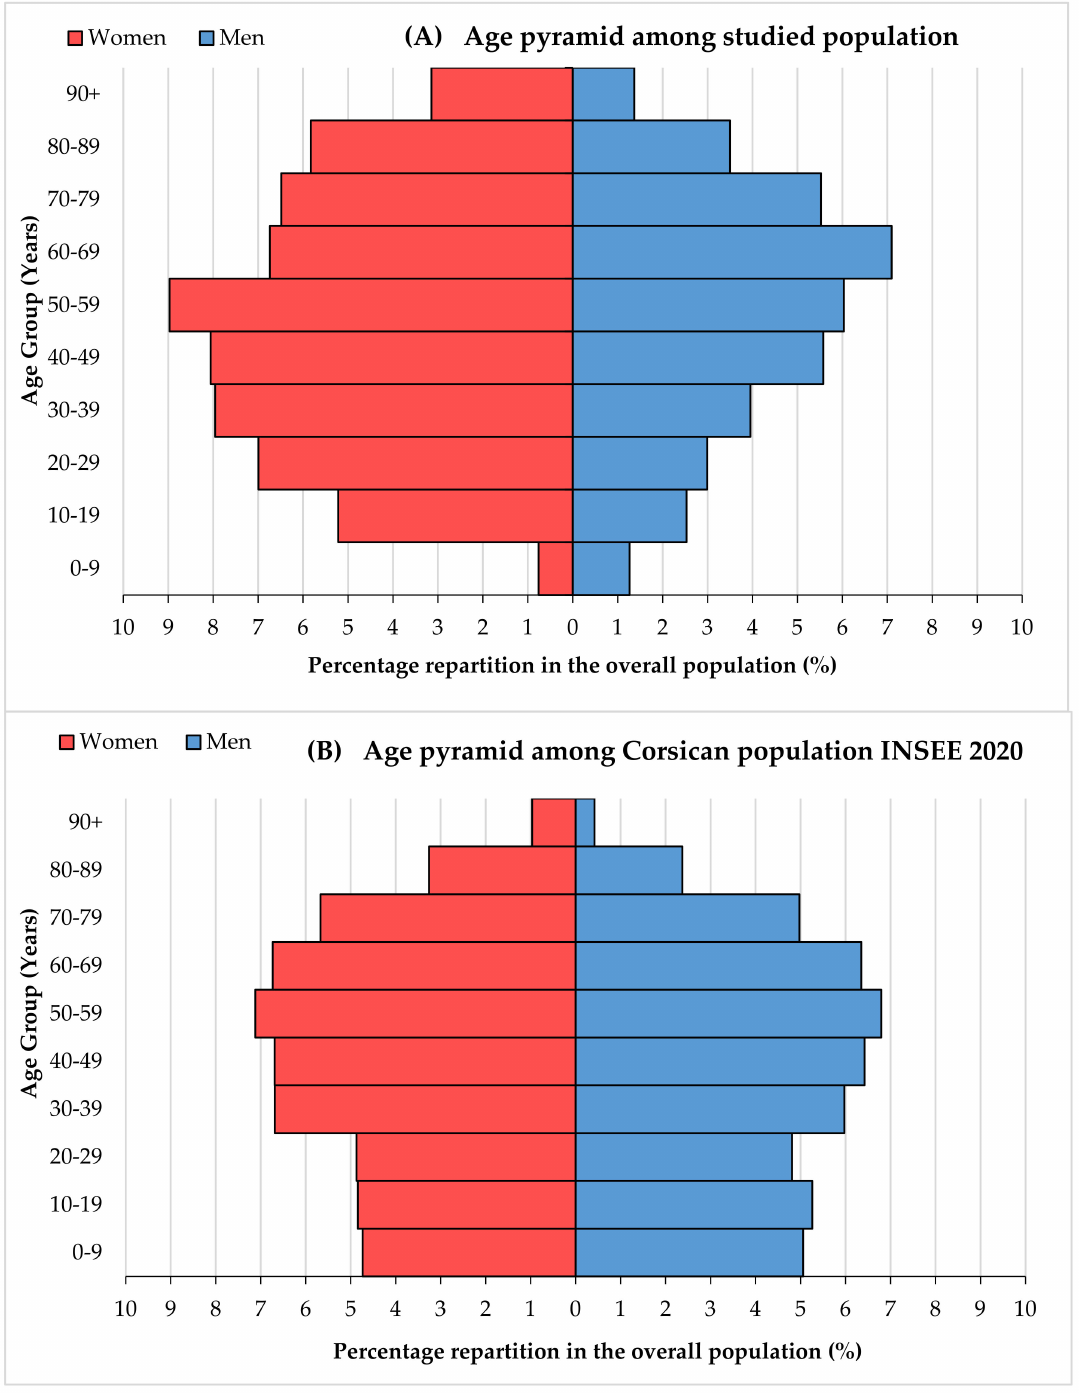
Figure A1. Age and sex repartition pyramid among Corsican population ( A ) and studied population ( B